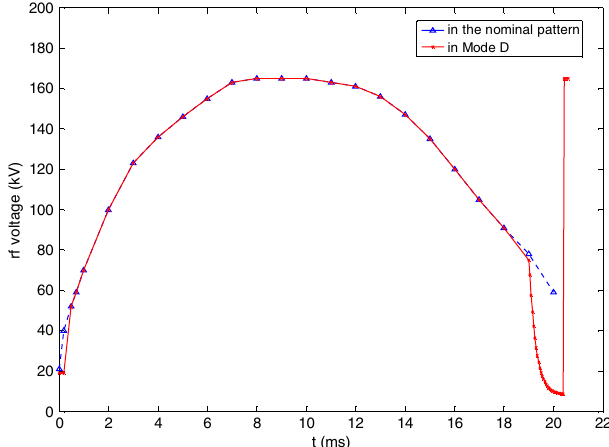
FIG. 2. Radio frequency voltage patterns of the nominal operation mode and the operation mode D with bunch compres- sion (defined in Sec. III). Blue dotted line with triangles: the nominal rf voltage pattern; red solid line with crosses: rf voltage pattern in mode D.